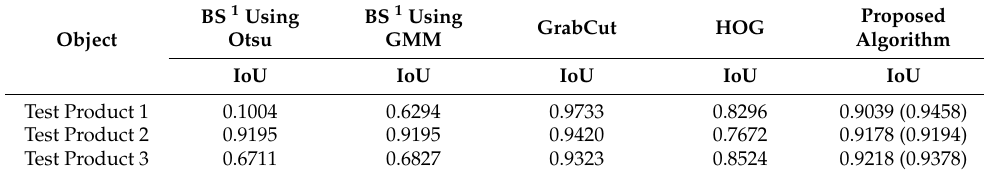
Table 1. Summary of test comparison